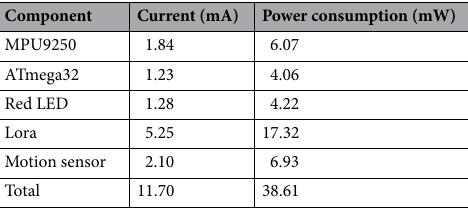
Table 1. Estimate of power consumption.